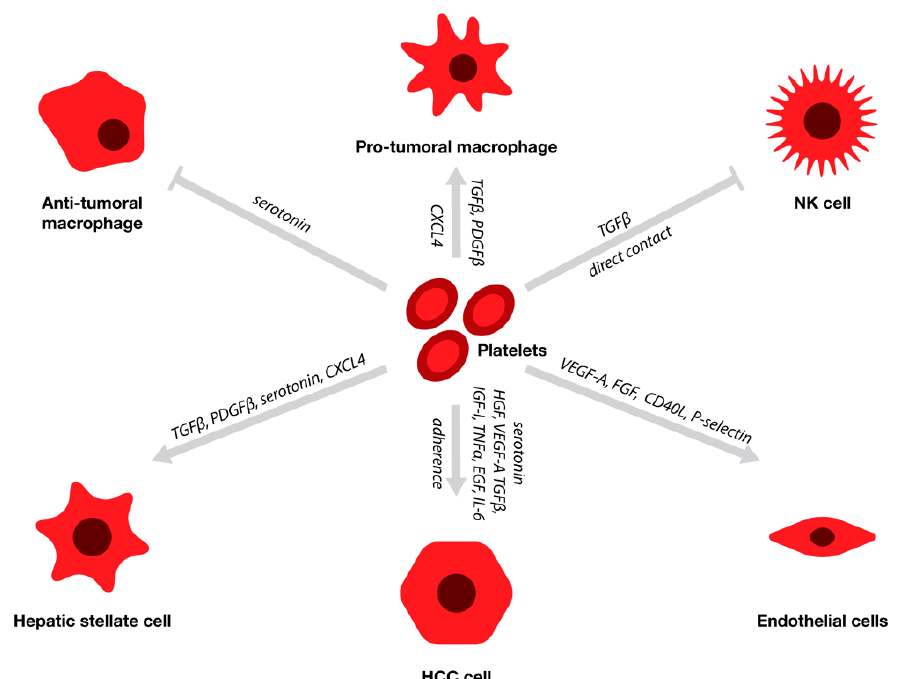
Figure 1. The interaction between platelets and different cells in the tumor and stromal compartments of hepatocellular carcinoma (HCC). Upon activation, platelets release α -granules and dense granules containing inflammatory cytokines, chemokines, and growth factors, such as platelet-derived growth factor beta (PDGF β ), serotonin, endothelial growth factor (EGF), insulin-like growth factor I (IGF-1) transforming growth factor beta (TGF β ), tumor necrosis factor alpha (TNF α ), interleukin-6 (IL-6), chemokine (C-X-C motif) ligand 4 (CXCL4), vascular endothelial growth factor A (VEGF-A), hepatocyte growth factor (HGF), and fibroblast growth factor (FGF). Platelets promote HCC cell proliferation, invasion, and chemoresistance, by releasing cytokines (serotonin, HGF, VEGF-A TGF β , IGF-1, TNF α , EGF, and IL-6) and by adhering to tumor cells, allowing them to avoid immunodetection. Their involvement goes beyond the direct e ff ect on tumor cells, as they also a ff ect the di ff erent cells in the stromal compartment, which creates an environment that stimulates tumor growth, invasion, and metastasis. Platelets release factors (mainly TGF β , PDGF β , serotonin, and CXCL4) that activate stellate cells, turning them in extracellular matrix (ECM) producing myofibroblasts which support tumor growth and aid metastasis. By secreting pro-angiogenic factors (VEGF-A and FGF) and by interacting with endothelial cells via CD40L and P-selectin, they contribute to the angiogenic switch, which increases the tumoral blood supply and facilitates vascular invasion. Platelets also play an important role in changing the hepatic immune cell population, as the release of microparticles containing serotonin, CXCL4, TGF β , and PDGF β promotes a shift from anti-tumoral macrophages to pro-tumoral macrophages, which are potent drivers of carcinogenesis. In addition, both the direct contact and release of TGF β can decrease the cytotoxic potential of natural killer (NK) cells, causing an immunosuppressive environment that benefits tumor